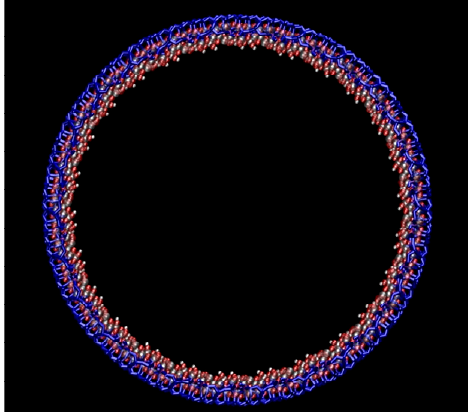
Figure 9. Optimization of the silica mesopore model. The blue lines represent the just-rolled silica cylinder. The optimized silica cylinder structure is represented by colored spheres: Si atom, gray spheres, O atoms, red spheres, H atoms, white spheres. The two structures are shown as projected along the z axis.